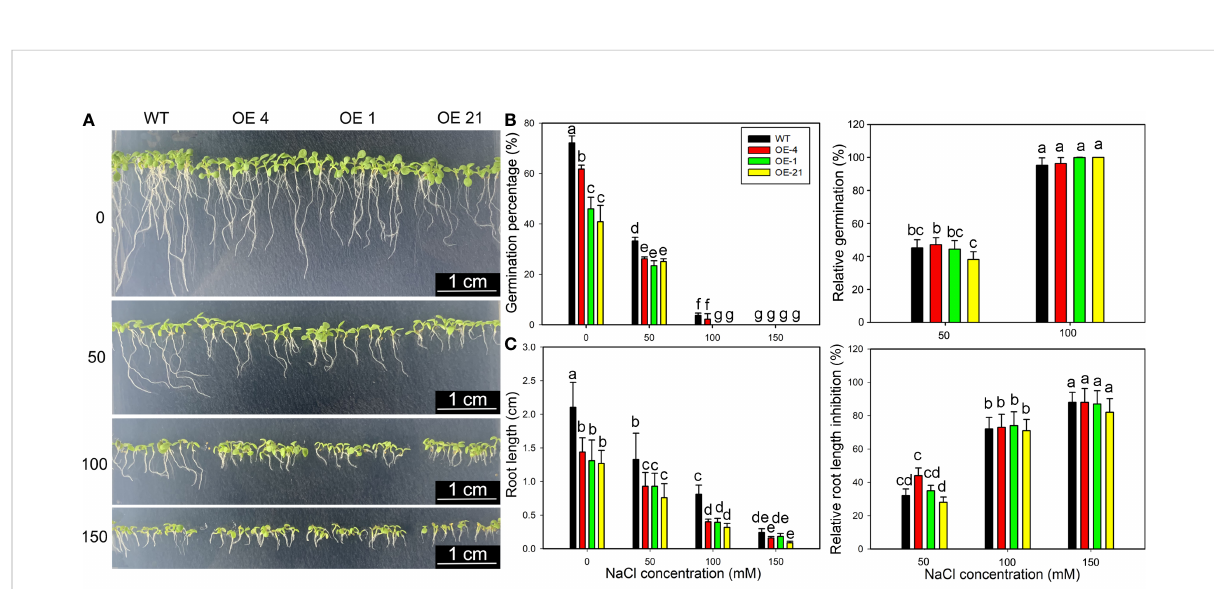
FIGURE 4 Growth characteristics of 35S:Lb1G04794 transgenic Arabidopsis lines following germination on different NaCl levels. (A) Phenotypes of WT and 35S:Lb1G04794 (OE 4, OE 1, and OE 21) Arabidopsis lines grown on half-strength MS medium (0) or different NaCl concentrations (50, 100, and 150 mM) for 5 days. (B) Germination percentages and germination inhibition percentages after 24 h at different concentrations of NaCl. The relative inhibition percentages of germination was calculated as (germination percentages under control – germination percentages under NaCl treatment)/germination percentages under control × 100%. (C) Root length and relative inhibition rate of root length elongation after 3 days at different concentrations of NaCl. The relative inhibition rate of root length elongation was calculated as (root length under control – root length under NaCl treatment)/root length under control × 100%. Fifty seeds per line were sown for each treatment, and three biological replicates were performed. The data for percentage germination are means ± SD. Root length of 5-day-old seedlings was measured in ImageJ. Data for root length are means ± SD of 10 seedlings per line; different lowercase letters indicate signi fi cant differences at P = 0.05 according to Duncan ’ s multiple range